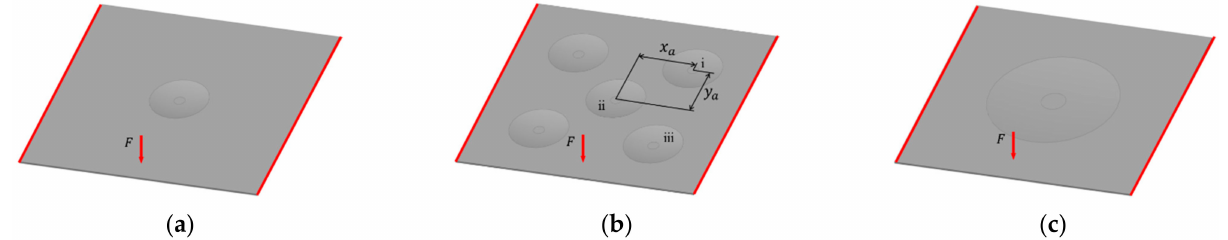
Figure 3. FE models of the plate embedded with two-dimensional ABHs: ( a ) a single ABH, ( b ) ABH array with 5 ABHs, ( c ) a big ABH.